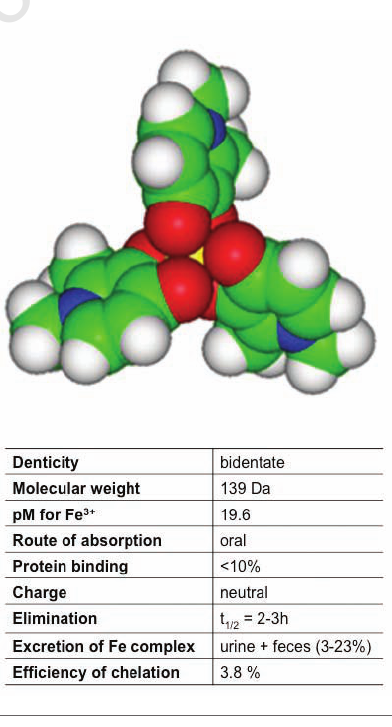
Figure 7. Structure of the deferiprone/iron complex. Three molecules of deferiprone bind one iron atom